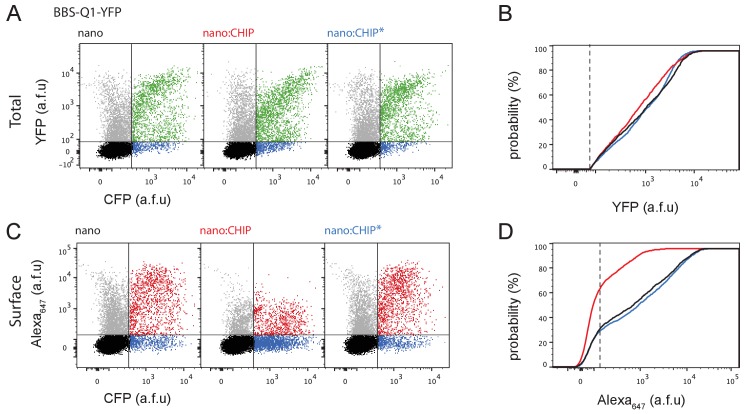
Catalytically inactive nanoCHIP* has no effect on Q1 surface expression.(A) Flow cytometry analyses of total Q1 expression (YFP fluorescence) in cells expressing BBS-Q1-YFP + nanobody (left, control), BBS-Q1-YFP + nanoCHIP (center), and BBS-Q1-YFP + nanoCHIP* [Δ128–229] (right). (B) Cumulative distribution histograms of YFP fluorescence for BBS-Q1-YFP co-expressed with either nanobody alone (black line), nanoCHIP (red line), and nanoCHIP* [Δ128–229] (blue line). (C) Flow cytometry analyses of surface Q1 channels (Alexa647 fluorescence) in cells expressing BBS-Q1-YFP + nanobody (left, control), BBS-Q1-YFP + nanoCHIP (center), and BBS-Q1-YFP + nanoCHIP* [Δ128–229] (right). (D) Cumulative distribution histograms of Alexa647 fluorescence for BBS-Q1-YFP co-expressed with either nanobody alone (black line), nanoCHIP (red line), and nanoCHIP* [Δ128–229] (blue line).